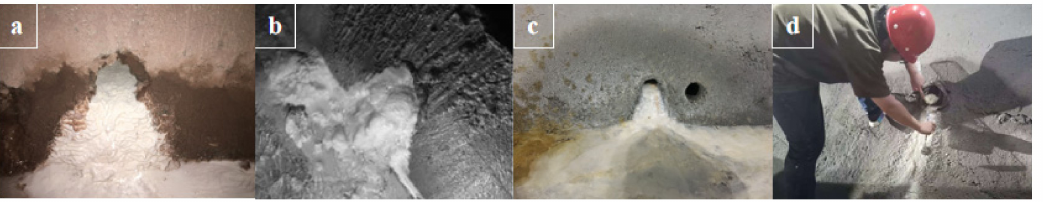
Figure 1. Crystalline plugging of tunnel drainage pipelines (( a ): Chongqing; ( b ): Yunnan; ( c ): Sichuan; ( d ):